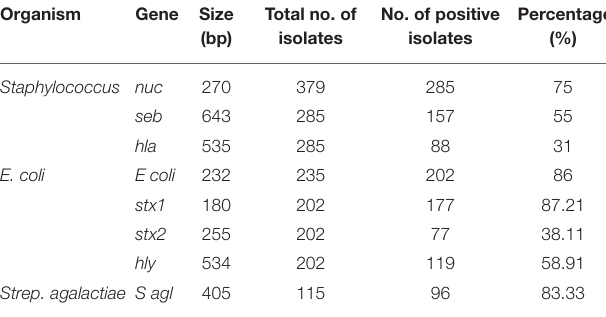
TABLE 6 | List of bacterial and their toxin genes found positive by molecular